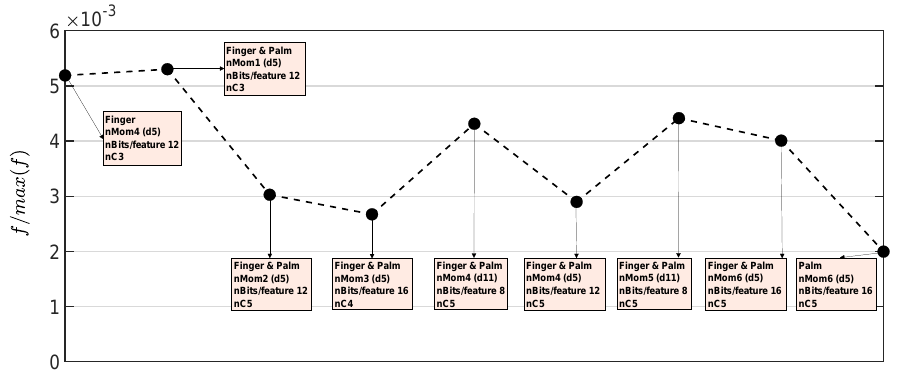
Figure 13. Result of the figure of merit in (2) normalized with respect to the best case in Figure 10. Finger&Palm (nMom1-12bits/ feature -d5-nC3) Accuracy: 94.6%